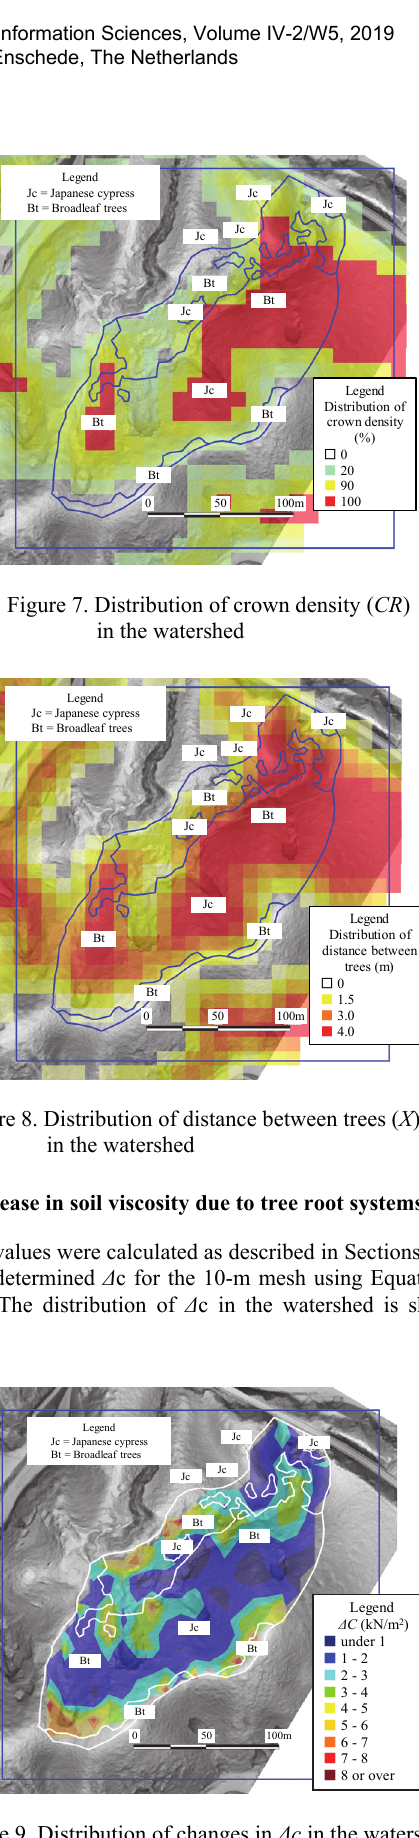
Figure 9. Distribution of changes in Δ c in the